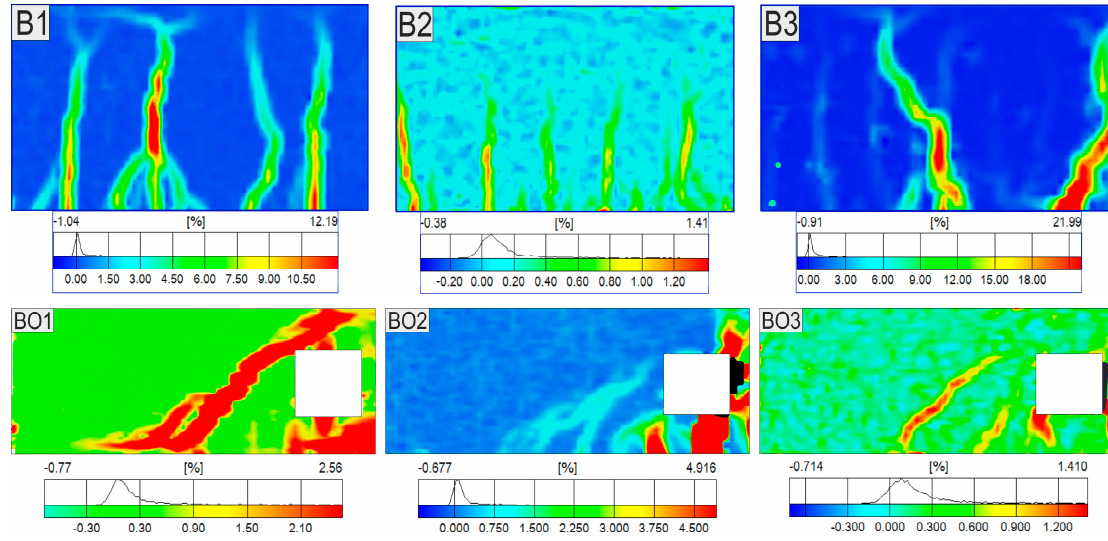
Figure 14. Major strains of beams in measurement area at maximum load.